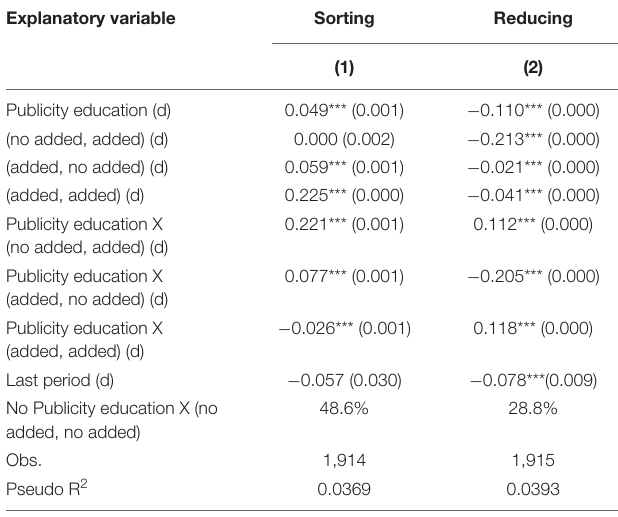
TABLE 11 | Probit regressions of publicity education and the combination of income changes on two